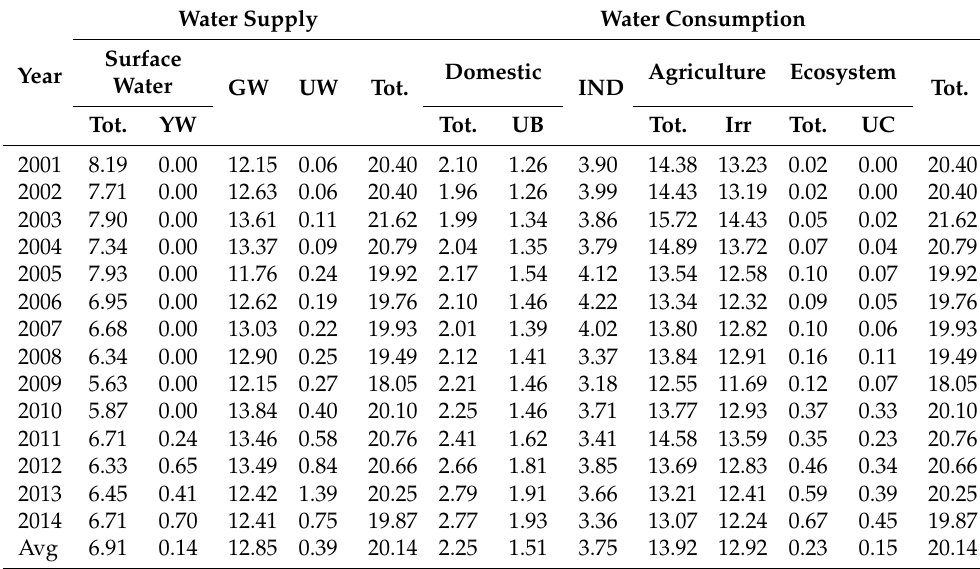
Table 7. Water supply and water consumption in the YD River Basin from 2001 to 2014 (10 9 m 3 ). Water Supply Water Year